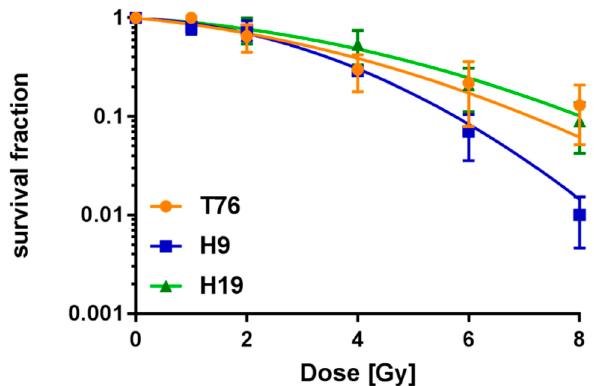
Figure 1. Survival fraction of three patient-derived glioma cell lines (T76, H9, and H19). Shown are three survival curves fitted with the linear-quadratic model after low linear energy transfer (LET) irradiation. Each survival fraction was calculated from three different measurement sets ( n = 3), and the standard error of the mean (SEM) is shown.